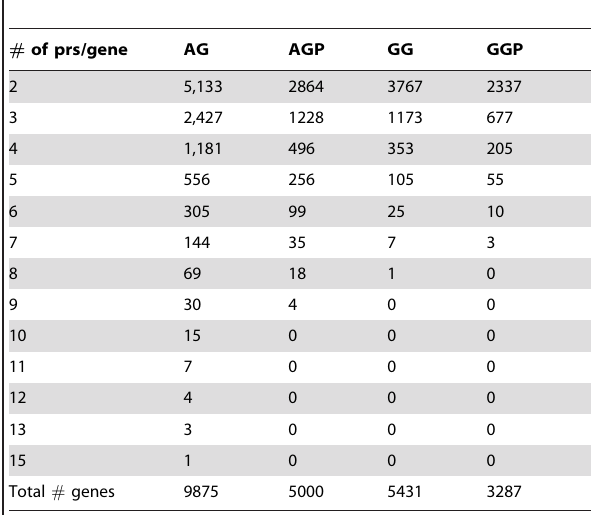
Table 1. Number of genes with redundant probe sets before and after filtering out the absent probe